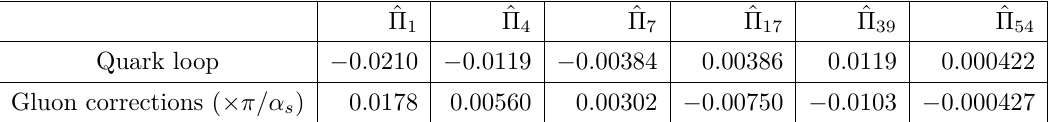
Table 3 . Values for the quark loop and gluonic correction contributions to the ˆΠ in GeV units for a benchmark tuple ( Q 2 , Q 2 , Q 2 ) = (1 , 1 . 3 , 1 . 7) GeV 2 . Sum over the three flavours has been made. 1 2 3 The last line is in units of α s /π